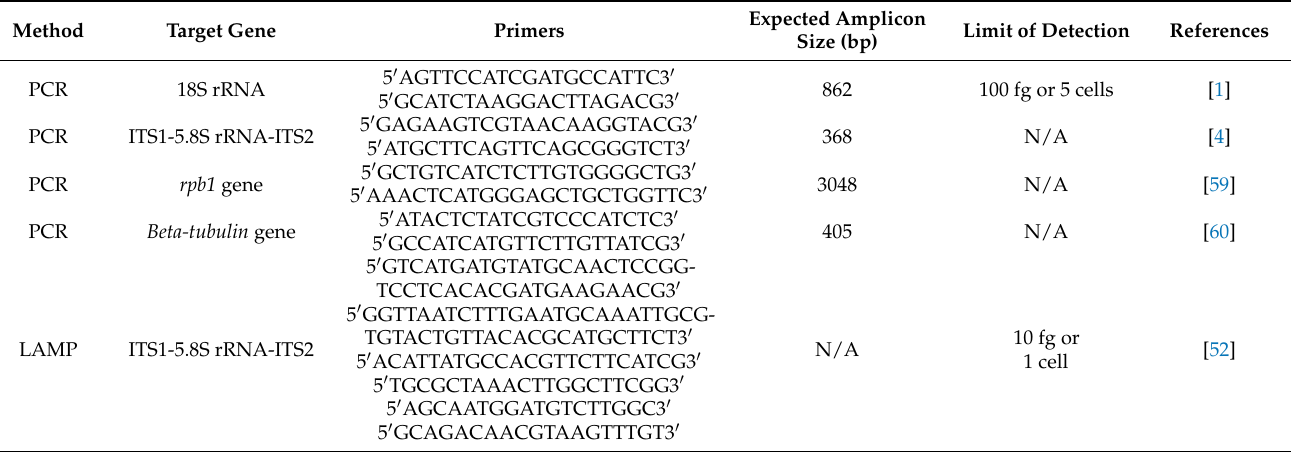
Table 3. Molecular diagnosis of Trichomonas tenax .